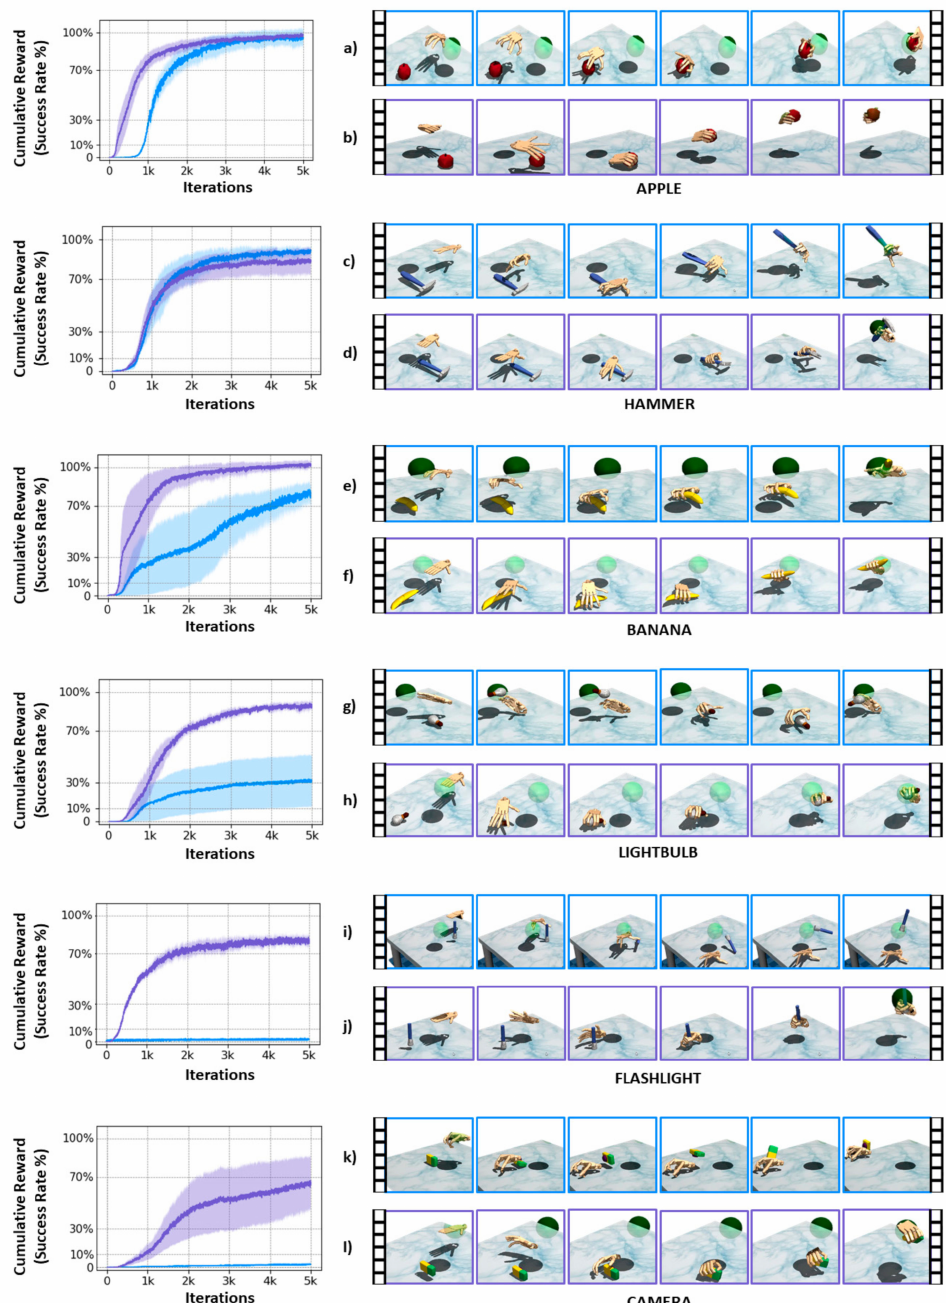
Figure 5. The left column shows the average sum of rewards from training the manipulation task with the proposed synergy-based DRL in purple and synergy-less standard DRL in blue. The solid line represents the mean and the shadow area of the standard deviation of the rewards. The right column shows the time-series frames from grasping and relocation of each object from apple, banana, hammer, lightbulb, flashlight, and camera with the standard DRL in the blue frames of ( a , c , e , g , i , k ), and the proposed synergy-based DRL in the purple frames of ( b , d , f , h , j , l